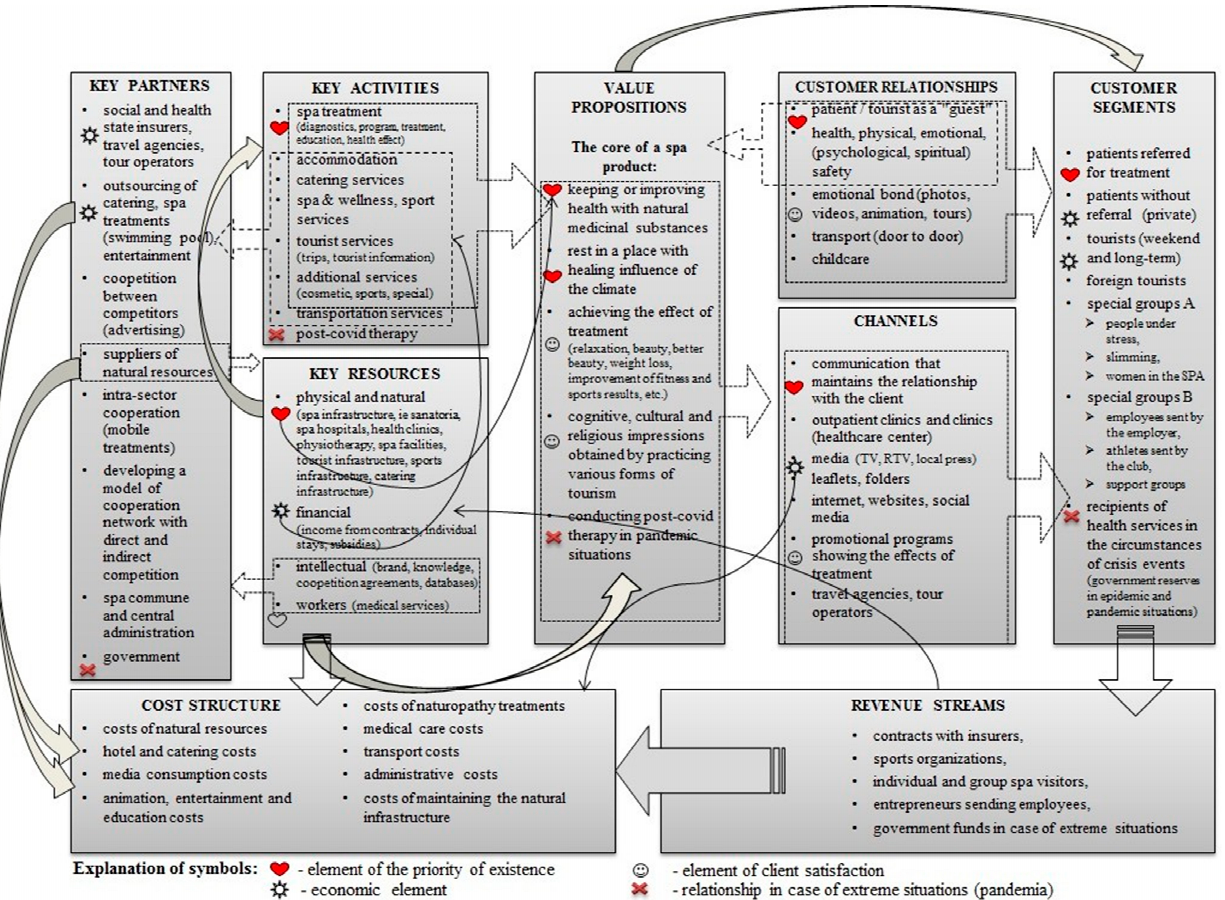
Figure 2. Segments of health resort services recipients. Source: Based on own study. Modern spa tourism enterprises service three segments of recipients. These are: (1) institutional recipients (contract recipients), (2) individual recipients (commercial recip ‐ ients), and (3) business recipients. The first segment—segment of institutional recipients (also known as contract re ‐ cipients)—is a group of leading health and social insurers that enter into agreements with health resort enterprises on behalf of the state ( Ф = 0.993). Beneficiaries of such benefits are the persons insured in the listed funds that receive benefits in set order. A specific feature of the market segment is the uniqueness of business relations taking place there. It is a market where the direct recipient of spa services is not the direct payer of the purchased services. On the other hand, an institutional recipient purchases a package of spa benefits, but does not use it, but only becomes its owner. At the same time, wanting to satisfy the need of a wide group of insured persons, it purchases such services led by the lowest unit price of the treatment. Unfortunately, such a situation re ‐ sults in lowered quality of services rendered to those who came to a health resort thanks to their insurance. For the enterprise, the contract stays, allowing it to receive low but stable revenues. The source of additional revenues is meeting the needs of the second segment of re ‐ cipients of spa services (individual recipients). These are people who pay for their stay in the spa themselves (individuals who came to health resort for health purposes, Ф = 1.000, and solely tourist purposes, Ф = 0.633). The prices of individual stays are usually much higher than the contractual stays. Therefore, the individual stays are very profitable for the health resort enterprise.